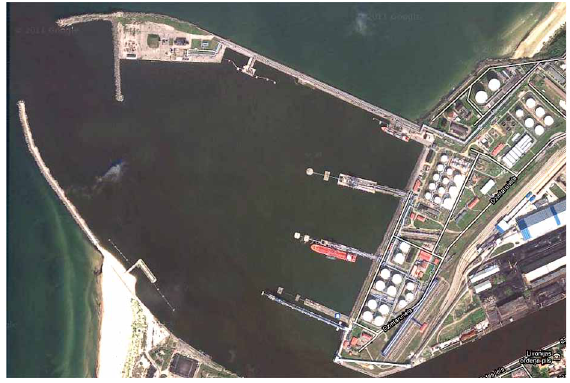
Fig. 1 . Jetties at the oil terminal in the Port of Ventspils (Latvia)